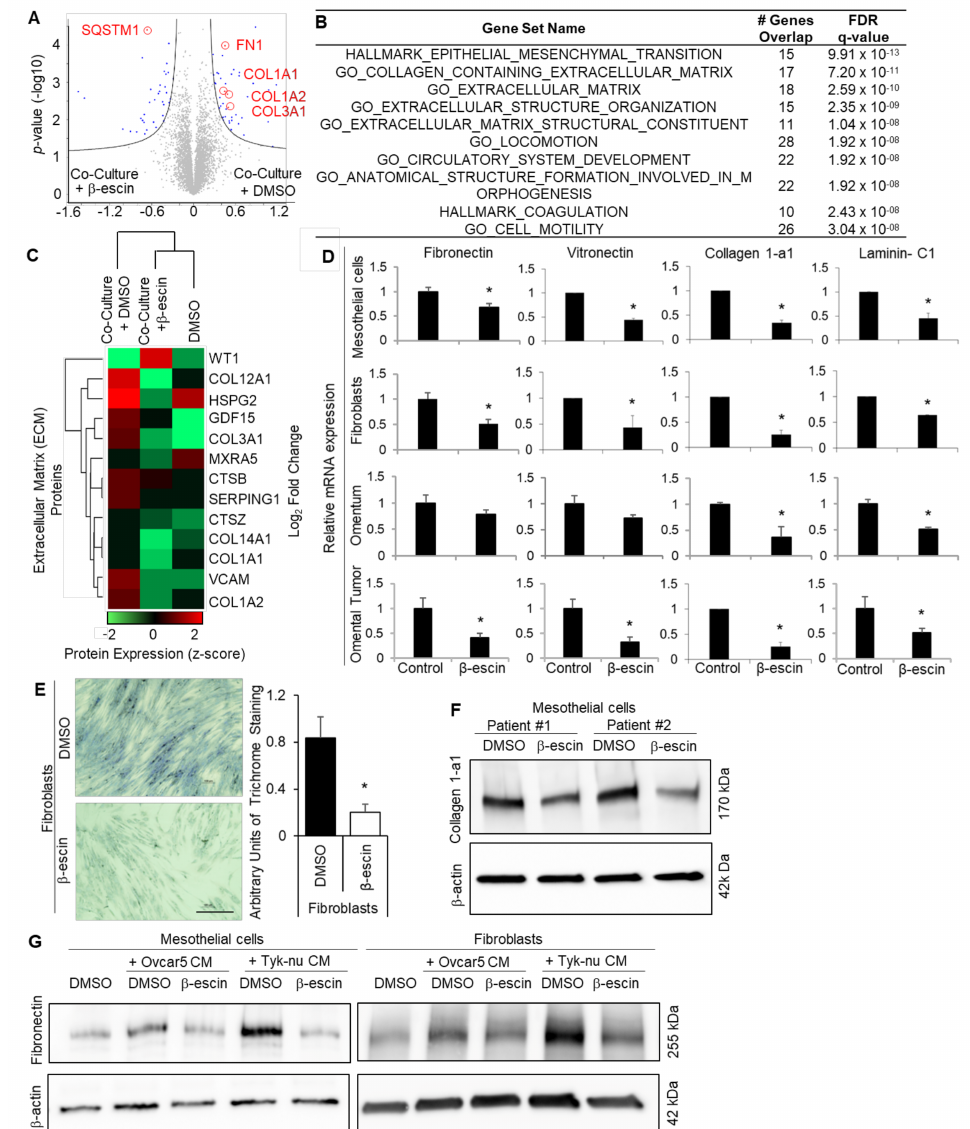
Figure 4. β -escin targets the extracellular matrix production in mesothelial cells. ( A – C ) Proteomics. Mass spectrometry analysis of the proteins extracted from the primary human mesothelial cells co-cultured with Tyk-nu OvCa cells and treated with DMSO (control) or β -escin (5 µ M) for 48 h. ( A ) Cell lysates were collected and measured on a Q Exactive HF mass spectrometer. Significantly altered proteins following exposure to Tyk-nu co-culture and DMSO or β -escin treatment (5 µ M) for 48 h (Volcano plot, Perseus), with the significantly altered proteins highlighted in blue. Significance was defined by an FDR of 0.05 and an S 0 value of 0.1 ( n = 4 patients per group in triplicate). The extracellular matrix proteins are defined and circled in red. ( B ) Gene set enrichment analysis (GSEA) of the proteins significantly altered by β -escin in mesothelial cells co-cultured with Tyk-nu cells. “Hallmark” and “Gene Ontology” datasets were included in the analysis. ( C ) Unsupervised hierarchical clustering (Perseus) was performed on the dataset from ( A ), assessing the extracellular matrix-related proteins. ( D ) The fibronectin, vitronectin, collagen-1a1, and laminin-C1 mRNA expressions were measured by qRT-PCR in primary human mesothelial cells, primary human fibroblasts, andex vivo human omentum culture or ex vivo human omental tumor culture after DMSO (control) or β -escin (5 µ M) treatment for 36 h (mean ± standard deviation; *, p < 0.05). ( E ) Collagen fibers were stained with trichrome stain (blue) in primary human fibroblasts after DMSO (control) or β -escin (5 µ M) treatment for 36 h (mean ± standard deviation. *, p < 0.05). ( F ) Collagen1-a1 immunoblot analysis of primary human mesothelial cells after DMSO (conrol) or β -escin treatment (5 µ M) for 48 h. ( G ) Fibronectin immunoblot analysis of primary human mesothelial cells and primary human fiboroblasts after no treatment (control) or OvCa cell line conditioned media (CM) treatment in combination with or without DMSO (control) or β -escin treatment (5 µ M) for 48